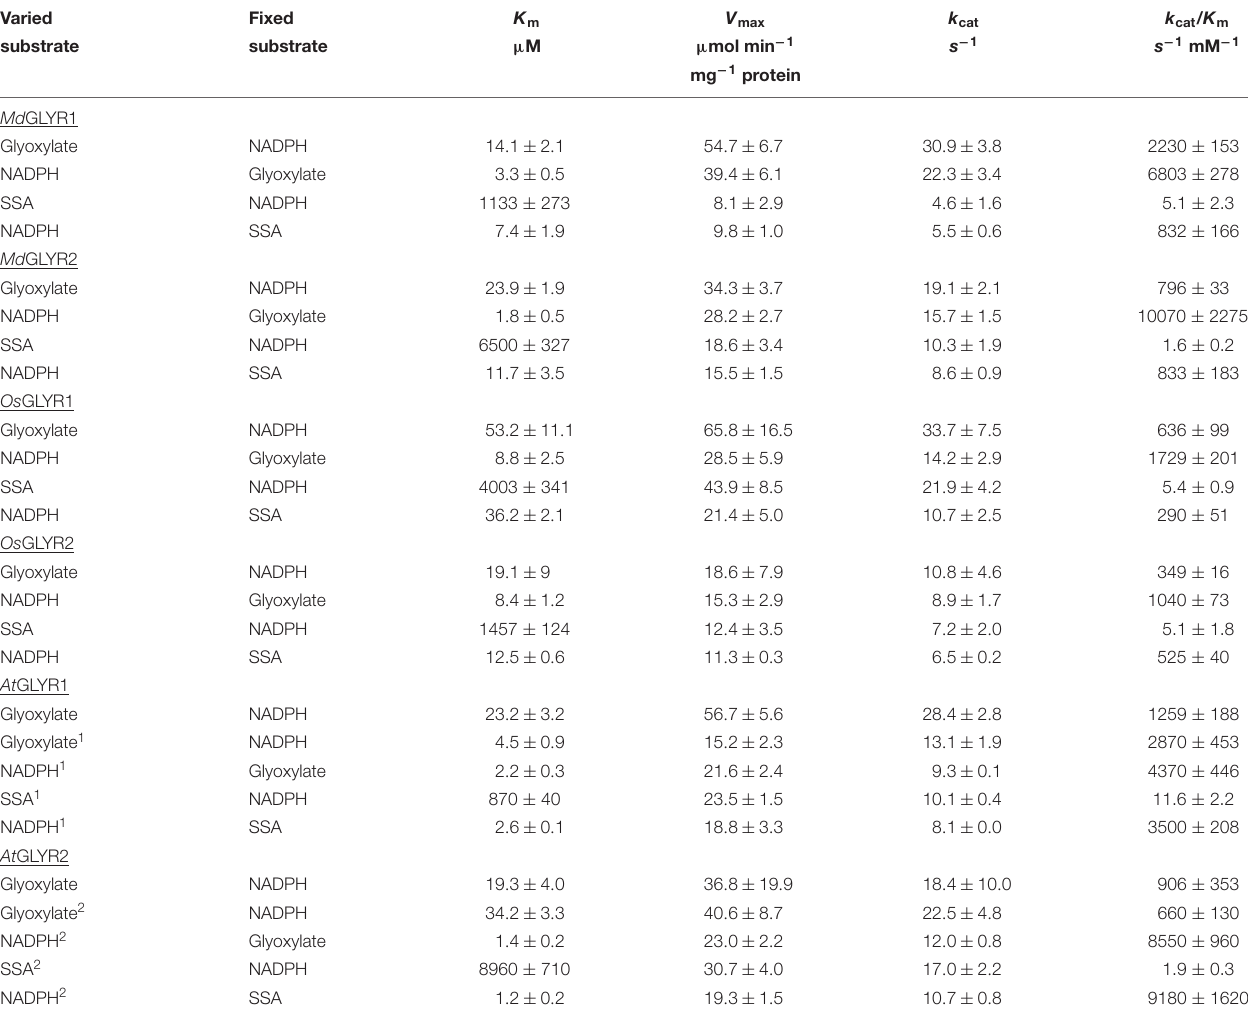
TABLE 1 | Comparison of the kinetic parameters for purified recombinant GLYRs from apple, rice, and Arabidopsis. Varied